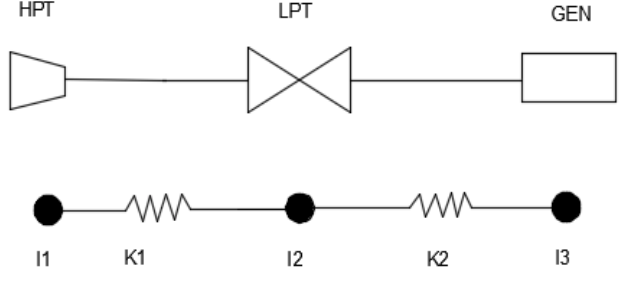
Figure 11. T/G mass-spring shaftline model.